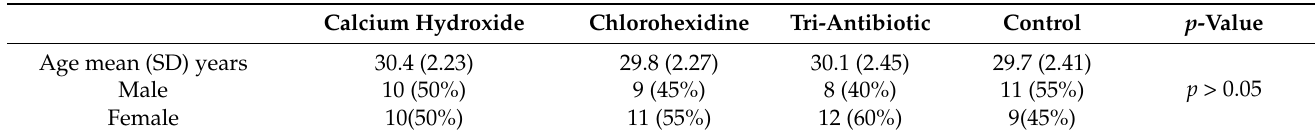
Table 1. Descriptive statistics of study